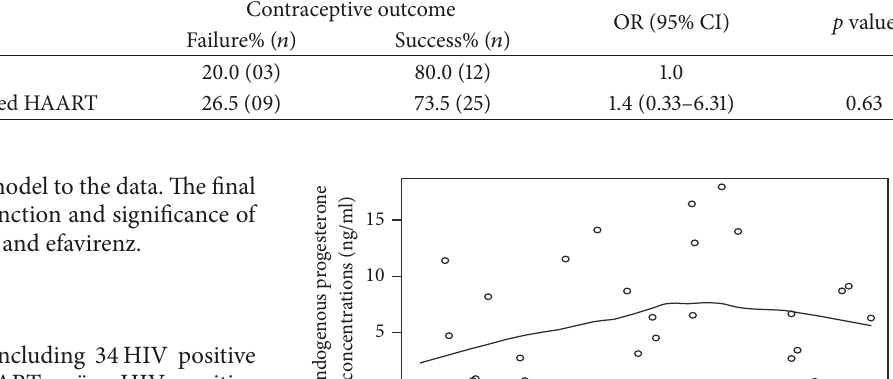
Contraceptive outcome OR (95% CI) p value Failure% ( 𝑛 ) Success% ( 𝑛 )